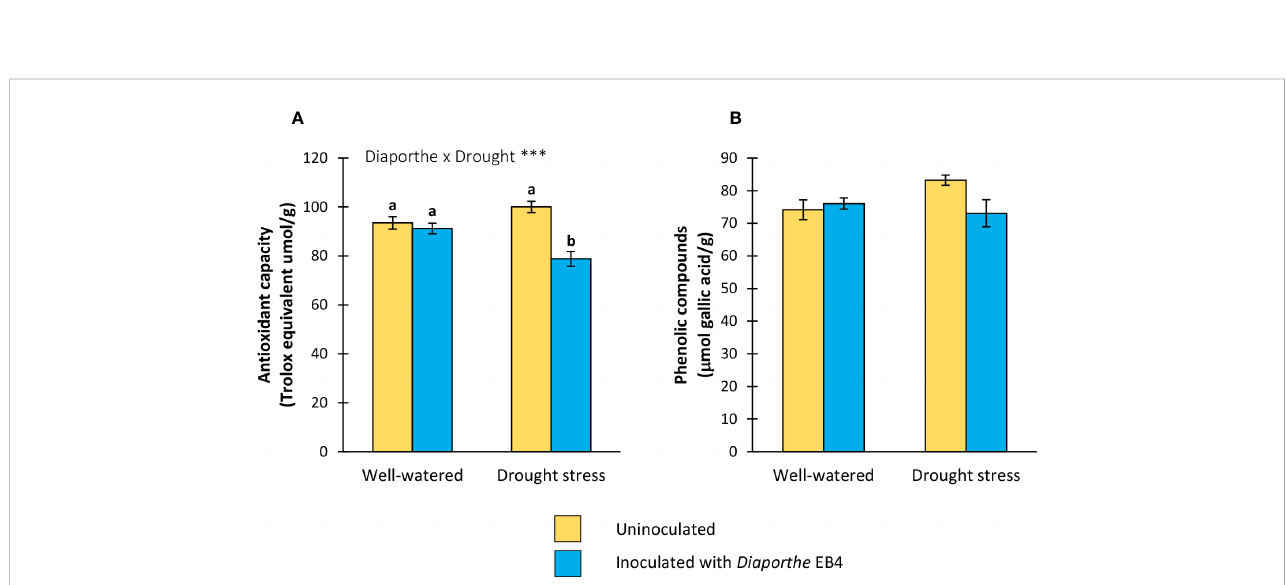
FIGURE 5 (A) Antioxidant capacity, and (B) total phenolic compounds content of tomato plants uninoculated (yellow) or inoculated with Diaporthe EB4 (blue), with two different water treatments (well-watered or drought stress). Different letters indicate different means (Tukey p <0.05) for the [ Diaporthe inoculation × Drought] interaction. Values are means ± SE (n=5). Level of signi fi cance: *** p